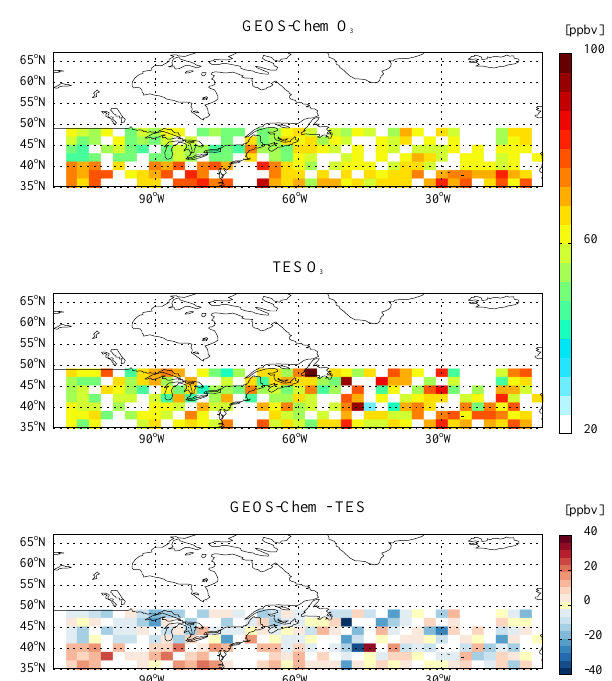
Fig. 7. Comparison of the mean mid-tropospheric (600–400hPa) ozone distributions modelled by GEOS-Chem and observed by the Tropospheric Emission Spectrometer and the difference (model mi- nus observed). The model ozone profiles have been smoothed by the TES averaging kernels and the TES bias has been removed as described in the text. The plots show the mean daytime ozone aver- aged over 12 July to 4 August